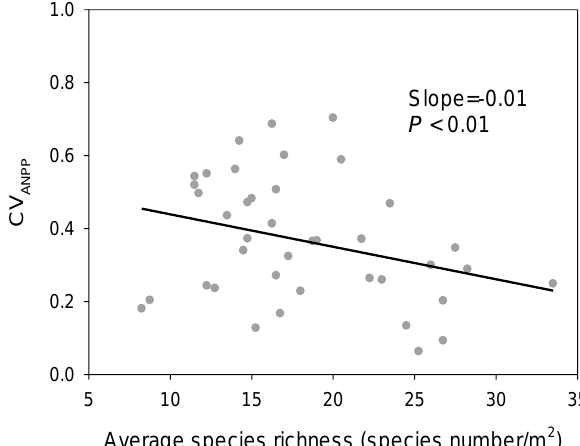
Fig. 6. Linear relationship between 4-year average of species rich- ness and CV of aboveground net primary production